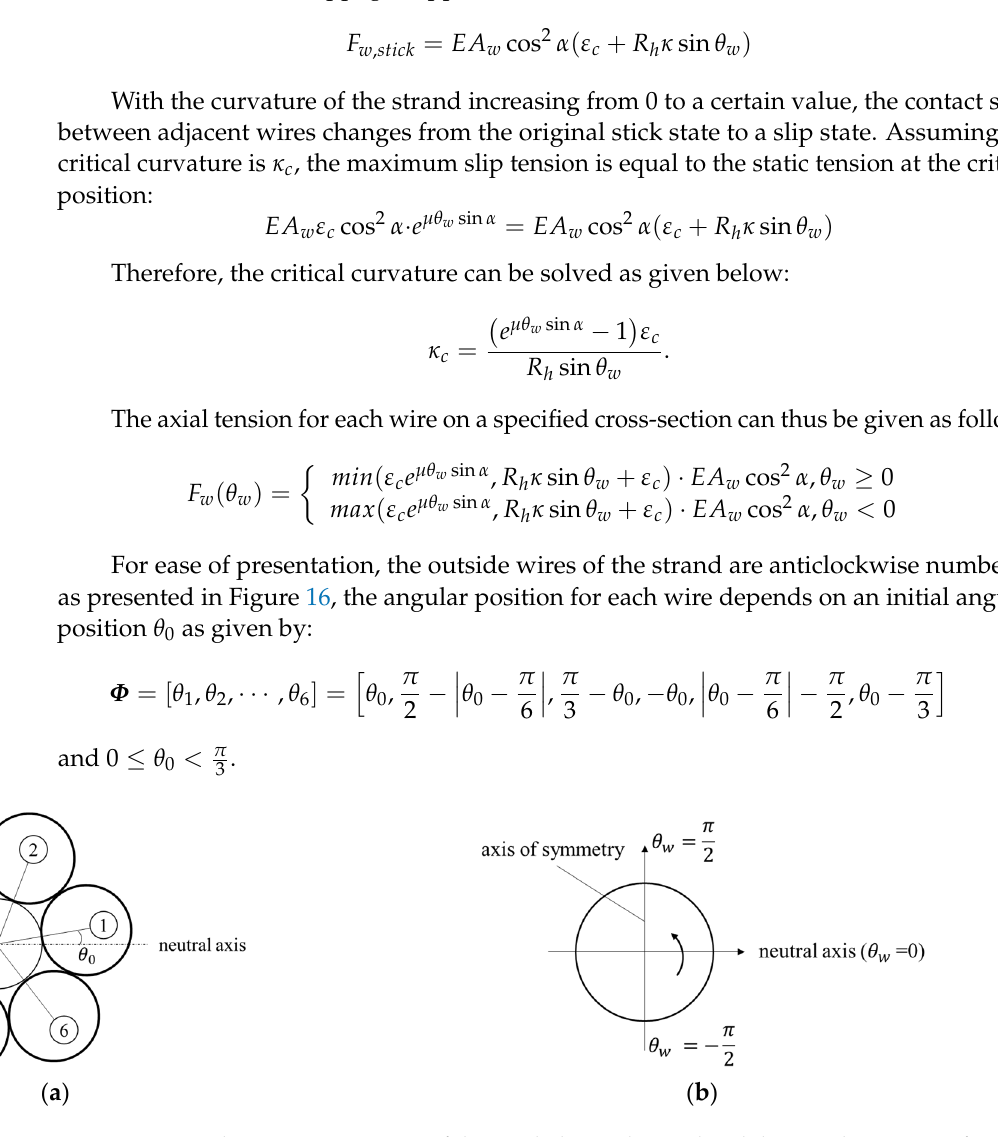
Figure 16. An arbitrary cross-section of the single-layered strand and the angular position for each wire cross-section: ( a ) the initial angular position of wire 1; ( b ) the definition of the angular position.